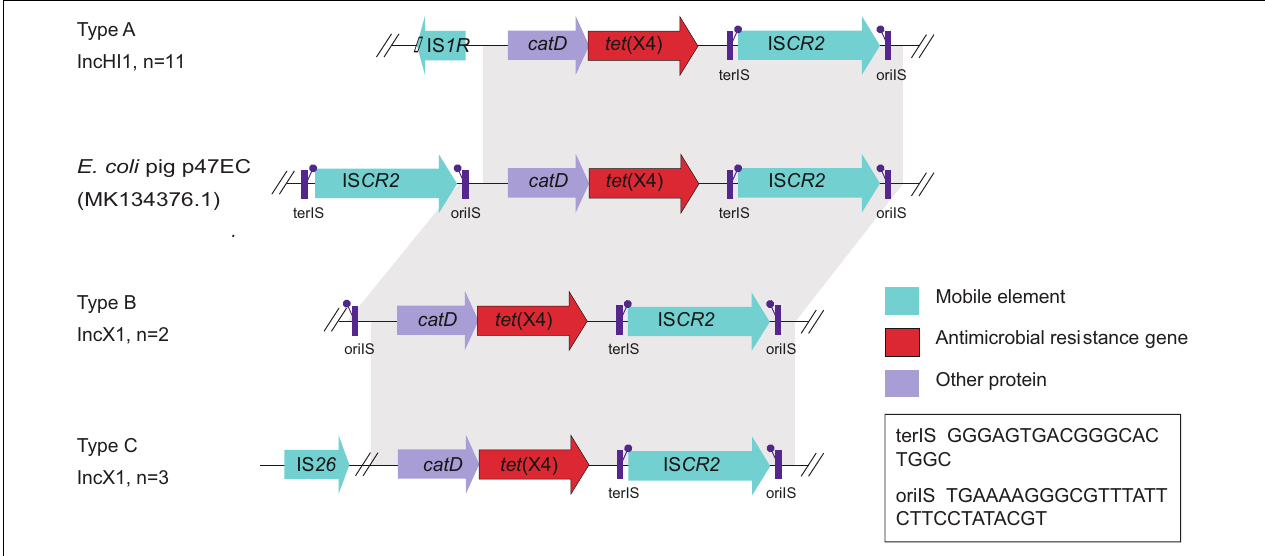
FIGURE 4 | Gene alignments of the tet (X4) in isolates from this study and the reported plasmid p47EC. Mobile elements, antimicrobial resistance genes, and other proteins are shown as blue, red, and purple arrows, respectively. Regions of homology between 73 and 100% are marked by gray